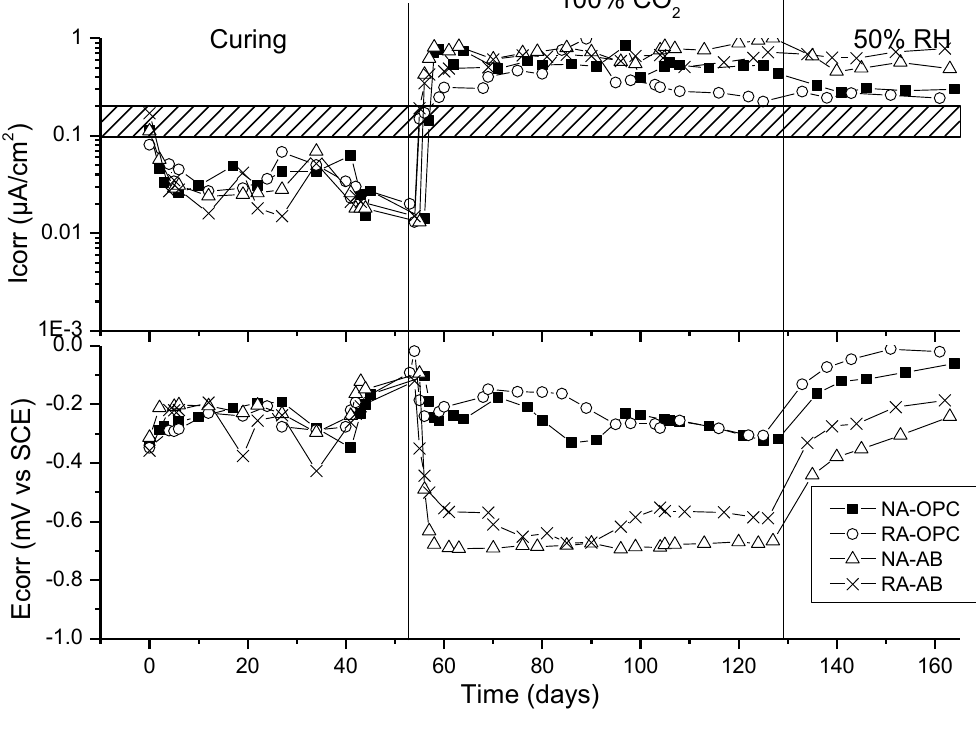
Figure 11. Corrosion rate and corrosion potential under accelerated carbonation